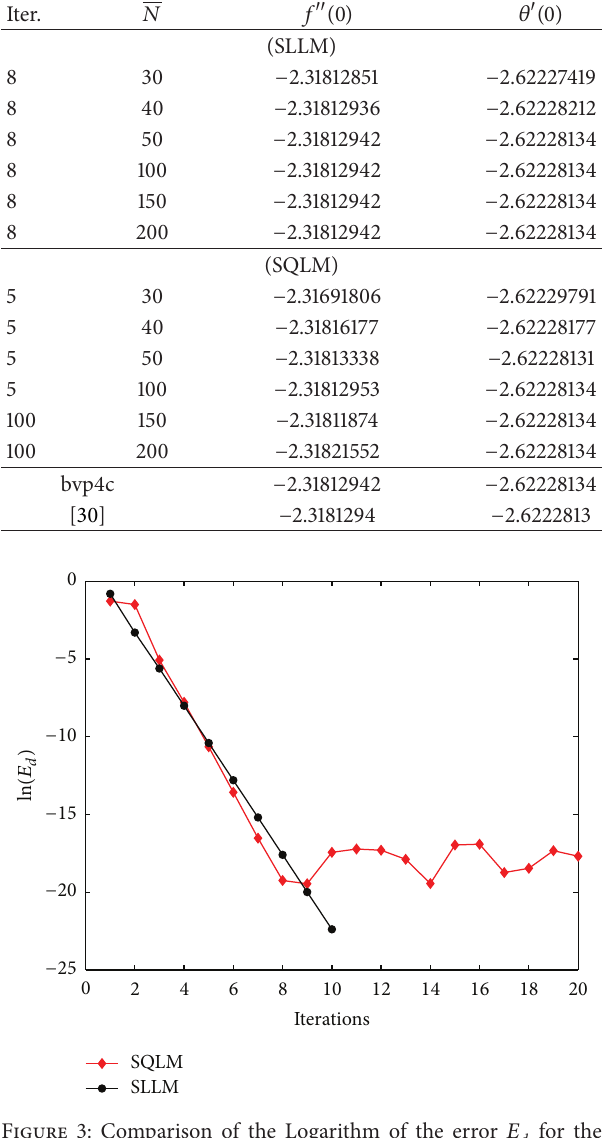
Figure 3: Comparison of the Logarithm of the error 𝐸 𝑑 for the unsteady boundary layer problem between the SLLM and SQLM results when 𝑁 = 150